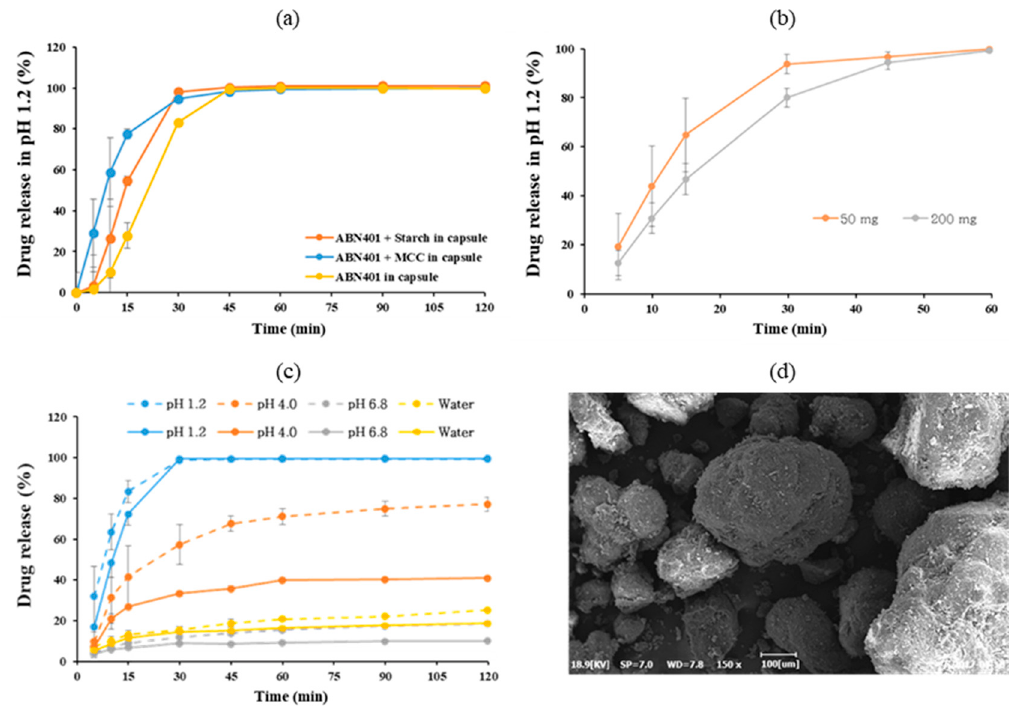
Figure 5. Dissolution profile of ABN401 in pH 1.2 of ( a ) physical blend in capsule with and without bulking agent (starch and MCC) at 50 mg, ( b ) a granulated blend in capsule at two doses (50 mg and 200 mg). ( c ) Dissolution profile of ABN401 at various pH values in gelatin capsule with optimized granulation at 50 mg (dotted) and 200 mg (solid) dose and ( d ) SEM image of the granulated blend.